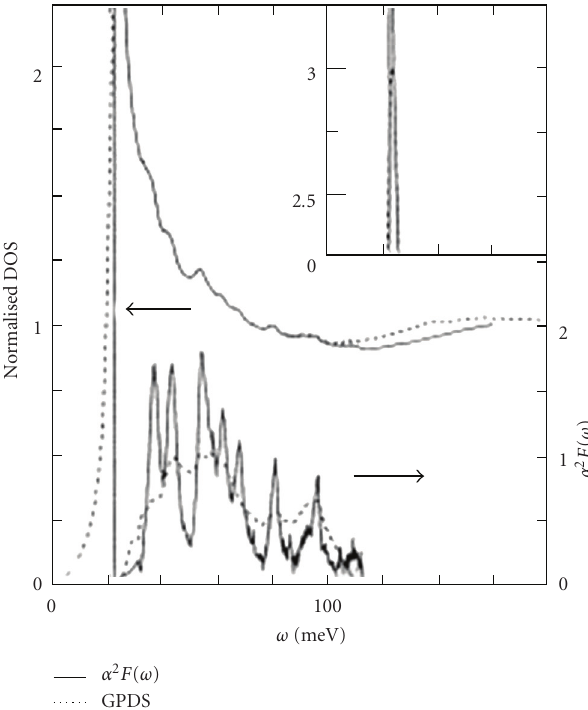
Figure 22: The spectral functions α 2 F ( ω ) and the calculated density of states at 0K (upper solid line) obtained from the conductance measurements, the Bi(2212)–Au planar junctions. GPDS—generalized phonon density of states. From [46, 47].